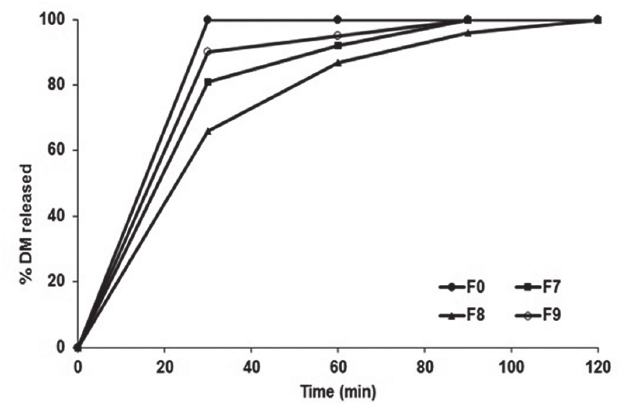
FIGURE 6 ‑ In vitro release profiles of DM from pellets formulations prepared from different carbopol concentrations.